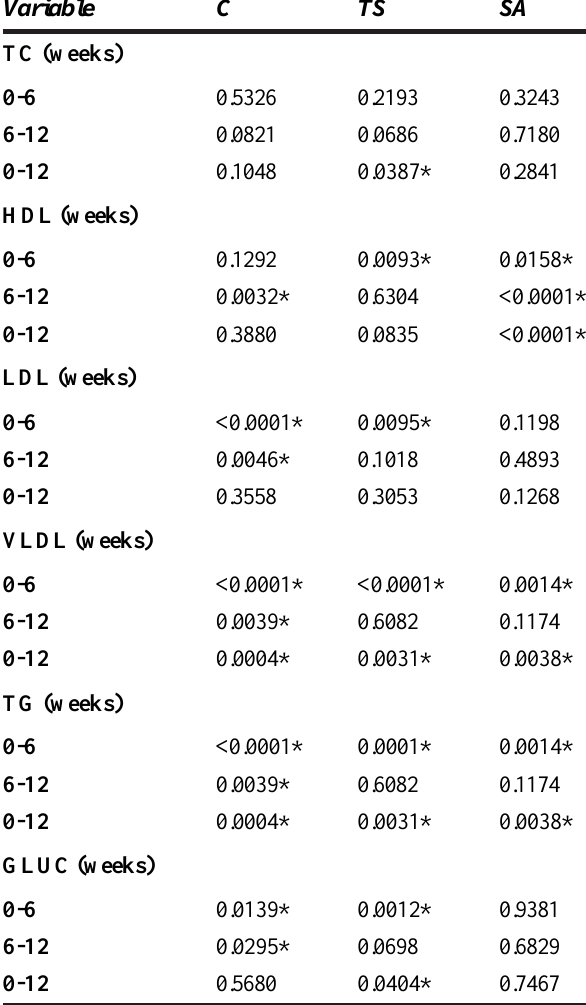
TABLE 2 - Descriptive analysis of the variables observed in weeks 0, 6, and 12 of the experiment in each group of animals – p